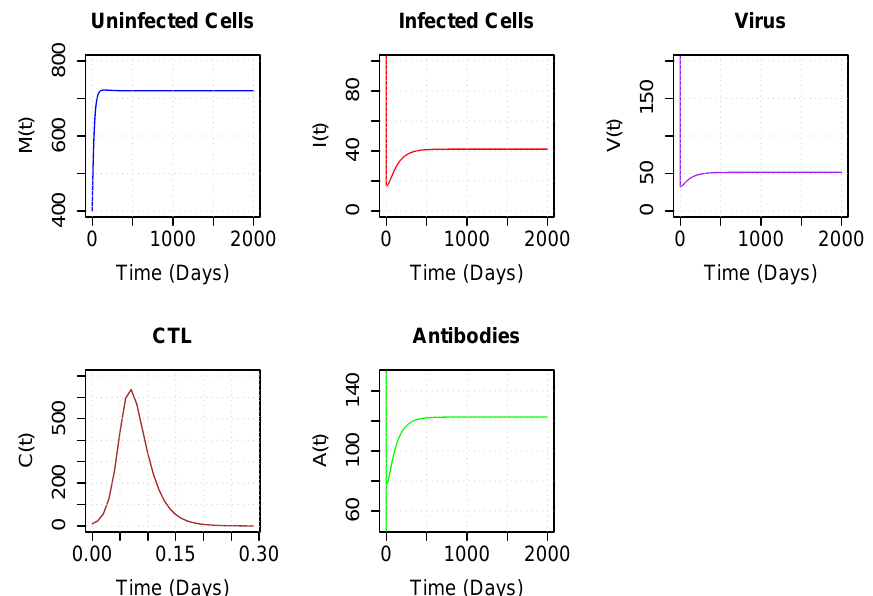
Figure 6. Trajectory plots of populations for parameters corresponding to the boundary region below the upper branch of the hyperbola. Parameter values are set to sample values of Table 1, with ψ = 0.7 and α = 130. Initial conditions are M 0 = 400, I 0 = 200, V 0 = 10,000, C 0 = 10 and A 0 = 2. Note the very brief time scale for C ( t ) quickly converging to 0 (under one